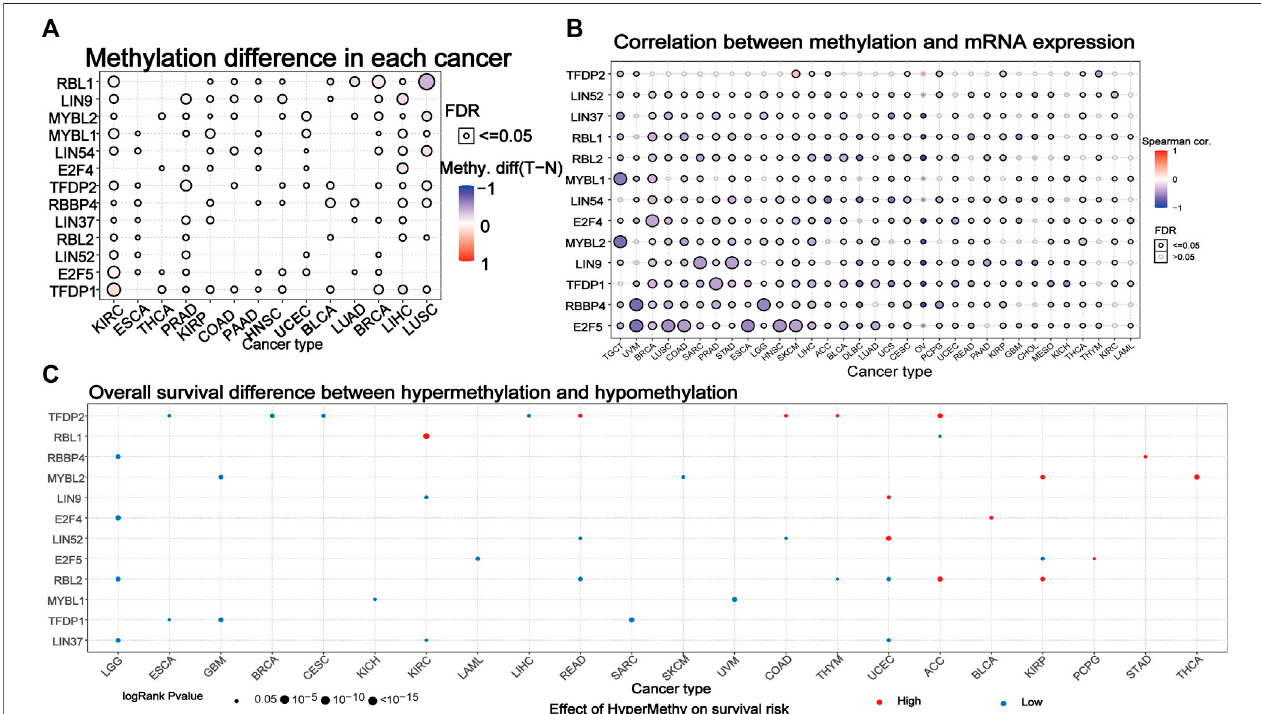
FIGURE 4 | Methylation of the DREAM complex. (A) Differential methylation of the DREAM complex between 14 paired normal and tumor tissues. Blue dots indicate adecrease in thedegree ofmethylation inthe tumor, red dots indicate an increase inthe degree ofmethylation in thetumor,the darker the color,the greater the difference in the degree of methylation. (B) Correlation between methylation and mRNA gene expression. Blue represents negative correlation, red represents positive correlation, the darker the color, the higher the correlation. (C) Survival difference between samples with the DREAM complex with high and low methylation. The red dot indicates that the survival rate ofthe hypermethylation group is lower, and theblue dot indicates that the survival rate ofthe hypomethylation group isbetter. The size of a point indicates statistical signi fi cance, and the larger the size of the point, the higher the statistical signi fi